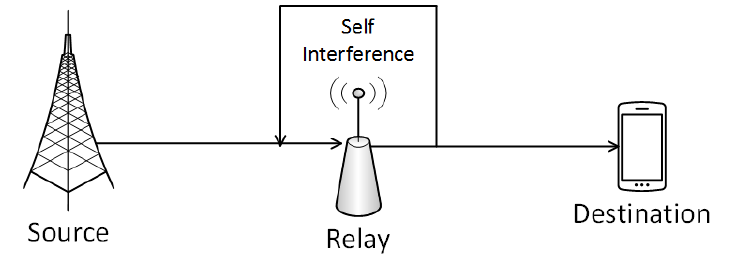
Figure 1. Self-interference in dual-hop full-duplex